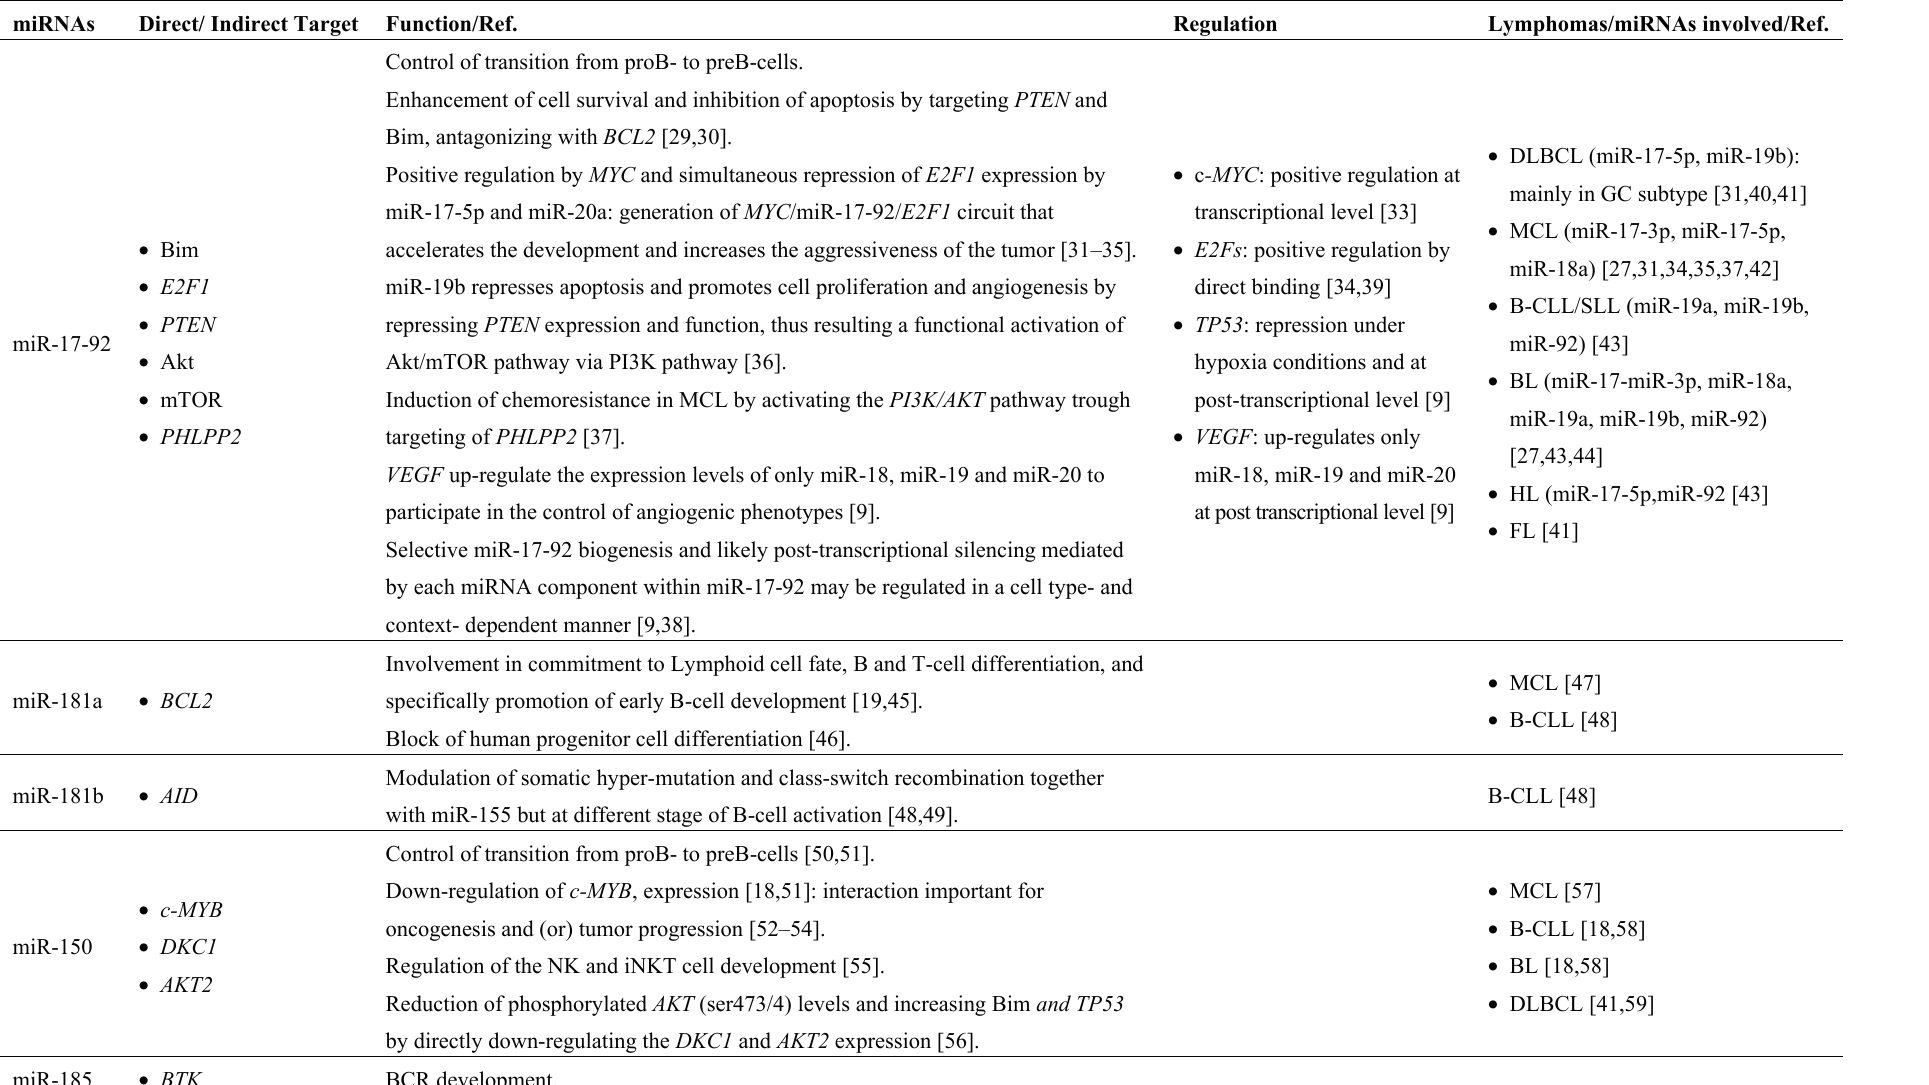
Table 1. The main miRNAs involved in the different stages of B-cell maturation and lymphomas listed with their functions and regulatory mechanisms. miRNAs Direct/ Indirect Target